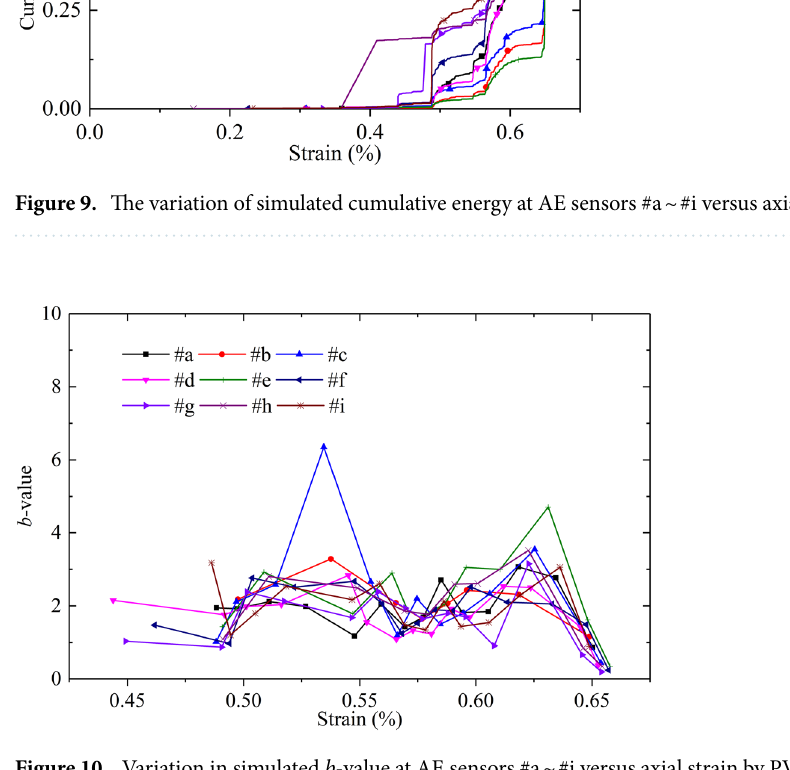
Figure 10. Variation in simulated b -value at AE sensors #a ~ #i versus axial strain by